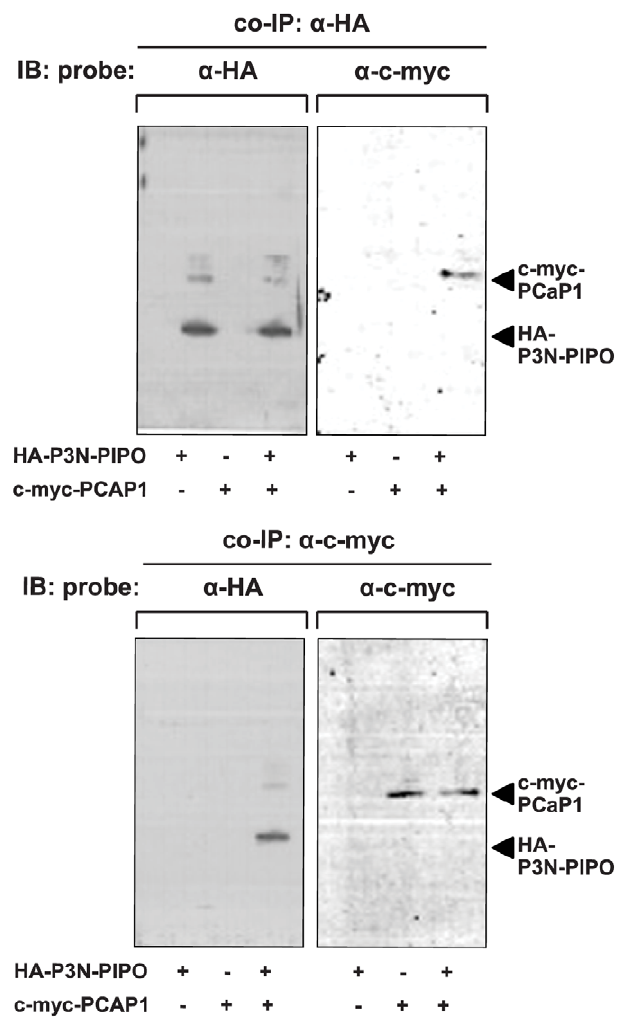
Figure 4. Co-immunoprecipitation of P3N-PIPO and PCaP1 expressed inplanta . Proteins from crude extracts of N. benthamiana leaves (2 days post agroinfiltration) that co-expressed HA-P3N-PIPO and c-myc-PCaP1, or expressed HA-P3N-PIPO or c-myc-PCaP1 only were pulled-down using anti-HA (top panels) or anti-c-myc (bottom panels) antibodies, separated by 4–12% Novex Tris-Glycine PAGE, electroblotted onto PVDF membrane and probed with anti-HA or anti-c-myc antibody as indicated. Recognition of HA-P3N-PIPO and c-myc-PCAP1 are shown at right. Immunoblotting (IB).